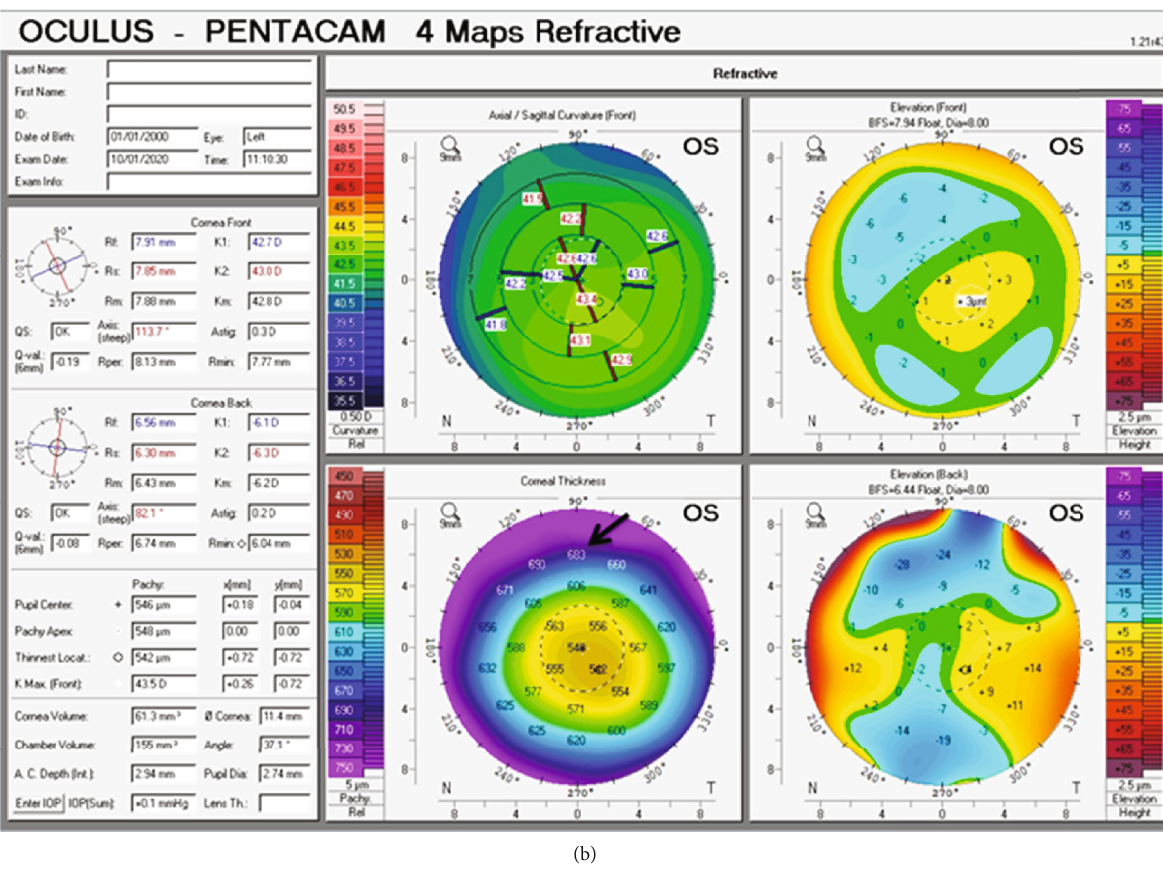
Figure 1: Corneal topography printouts of the right (a) and the left (b) eyes (Oculus-Pentacam). Corneal thickness maps show increased superior peripheral corneal thickness in both eyes due to copper deposition in Descemet's membrane (black arrows).